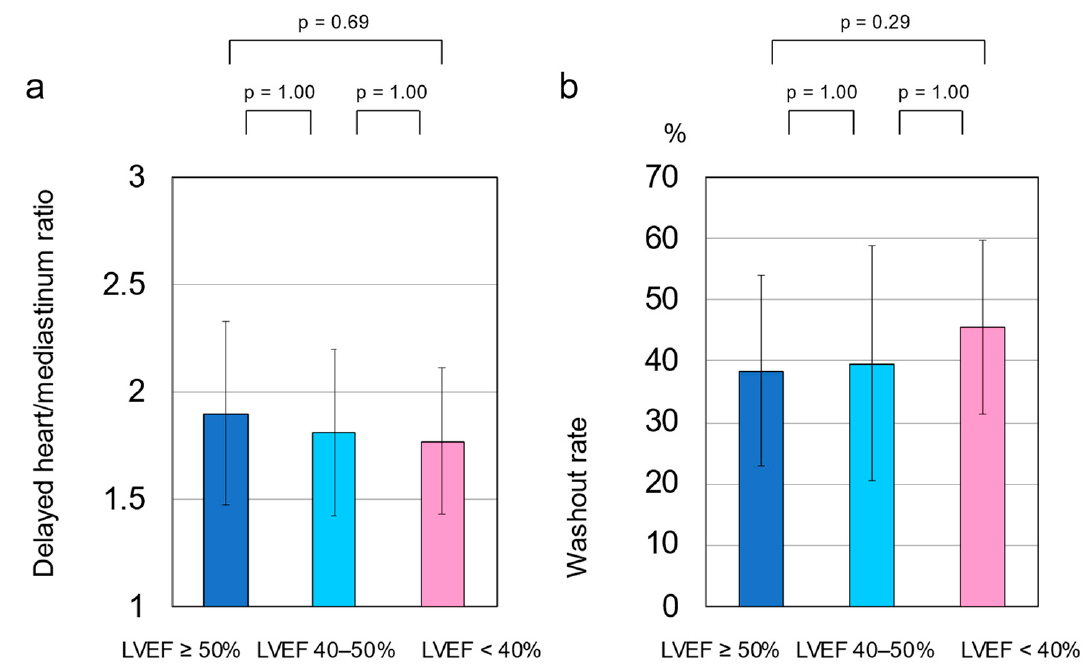
Figure 4. Comparison of the delayed heart/mediastinum ratio (H/M) and the washout rate (WR) among the three groups; LVEF ≥ 50% ( n = 22), LVEF 40–50% ( n = 9), and LVEF < 40% ( n = 32). No significant differences were observed in the delayed H/M ratio (1.9 ± 0.4 vs. 1.8 ± 0.4 vs. 1.8 ± 0.3, respectively, p = 0.48 ( a ) or WR (37.8 ± 15.7% vs. 39.7 ± 19.2%, vs. 45.5 ± 14.3%, respectively, p = 0.22 ( b ) among the three groups. These data were compared using an analysis of variance (ANOVA) with Bonferroni adjustment.